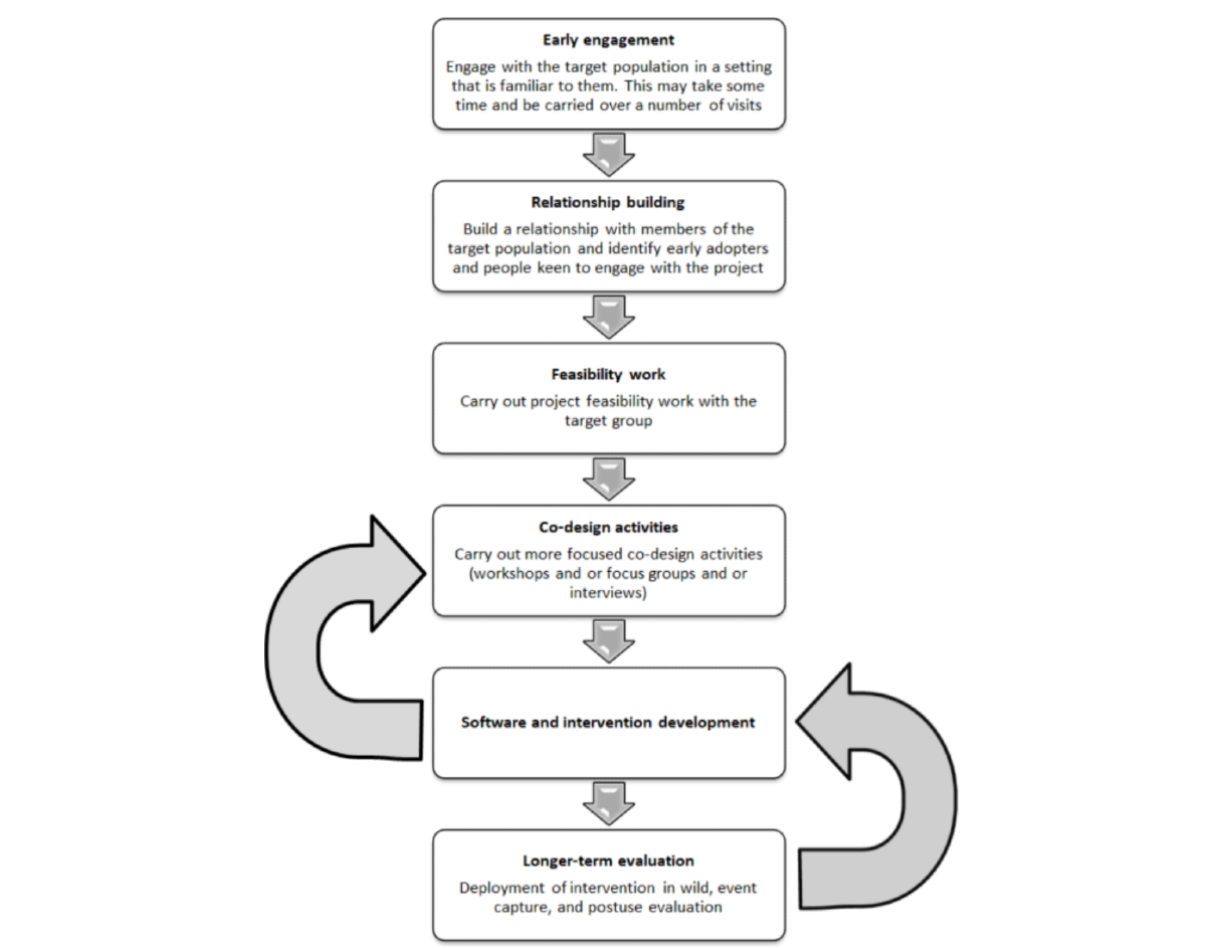
Figure 10. Recommended